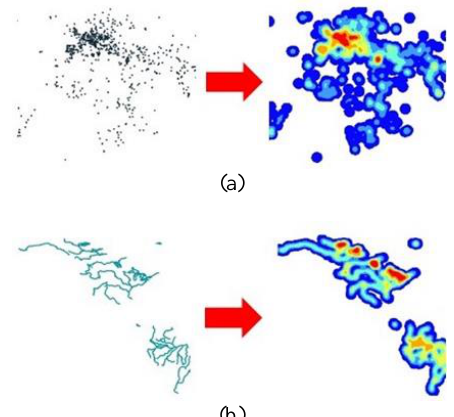
Figure 1 . The point-based and line-based kernel density